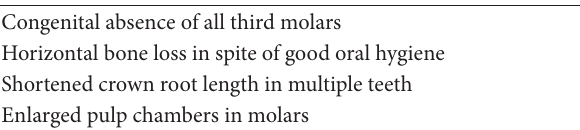
Figure 3: Pretreatment mandibular arch showing missing central incisors. Table 1: Dental findings in this report.